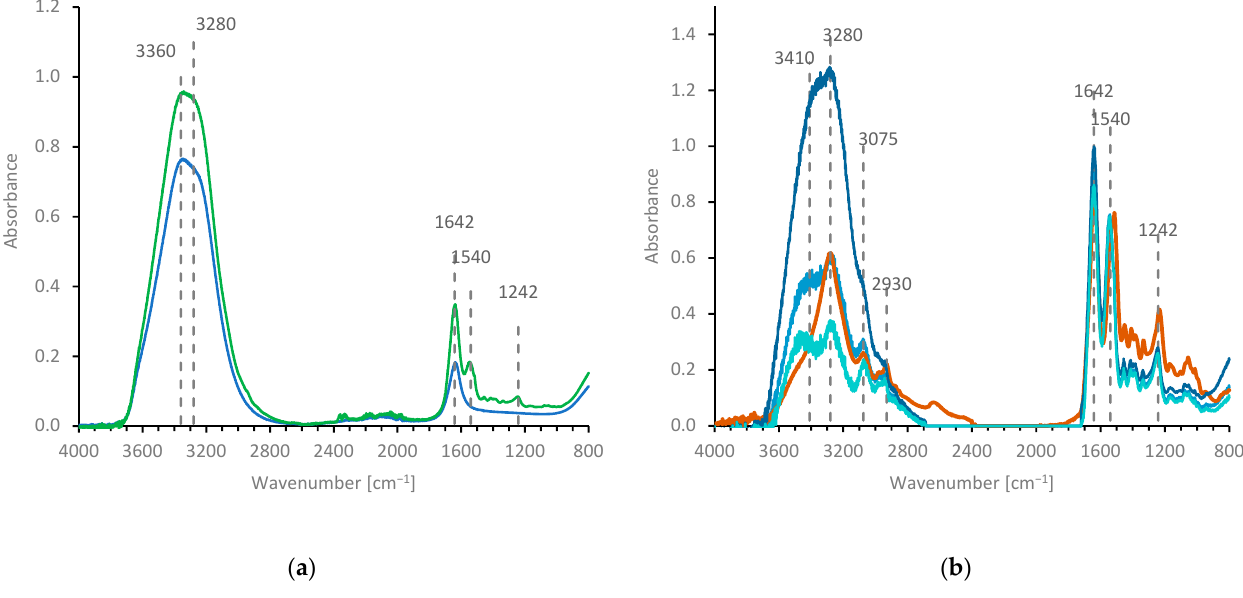
Figure 3. Mid-range IR data, collected using ATR: ( a ) NSF (green) and water (blue, scaled to match concentration in NSF); ( b ) dried fibroin film (brown) and difference spectra (NSF–water, various shades of turquoise) with the weighting factors for the water spectrum shown, then scaled to match the amide II peak intensity in the spectrum of the dry film.